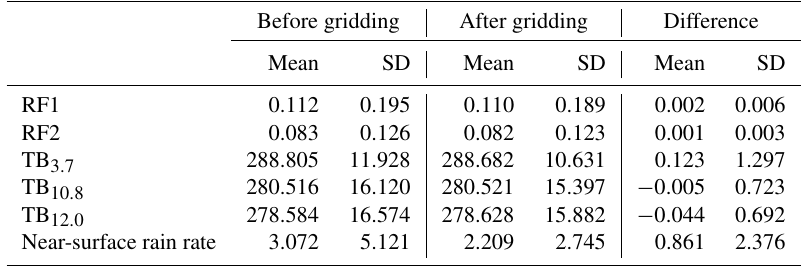
Table 2. Comparisons of statistical mean and standard deviation (SD) of the near-surface rain rate and signals from five channels in 1B01-